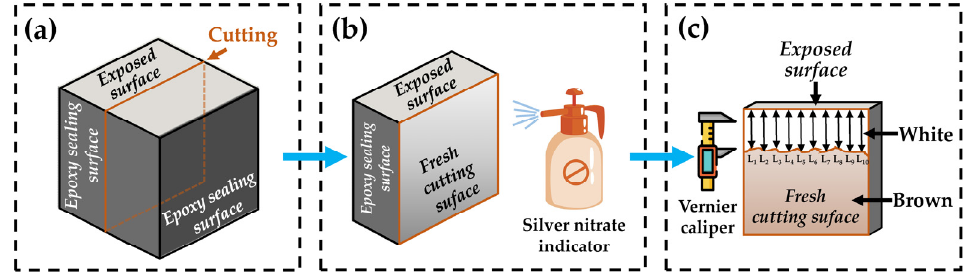
Figure 3. Measurement process of chloride ions’ penetration depth. ( a ) Specimen cutting, ( b ) indicator spraying, and ( c ) depth measurement.